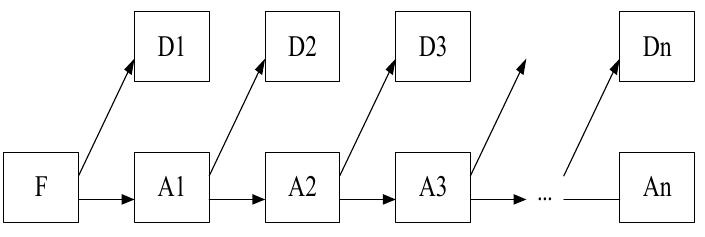
Figure 1. Schematic diagram of the wavelet decomposition principle.